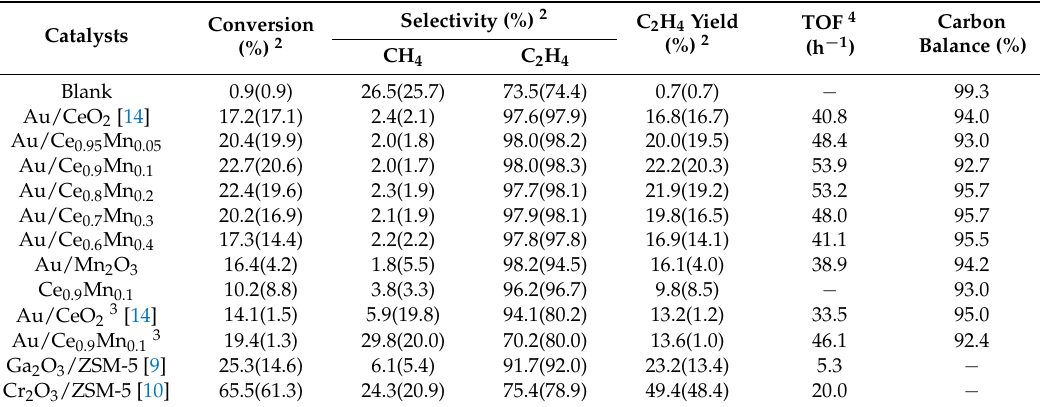
Table 3. Reaction data in the DHE in the presence of carbon dioxide 1 .